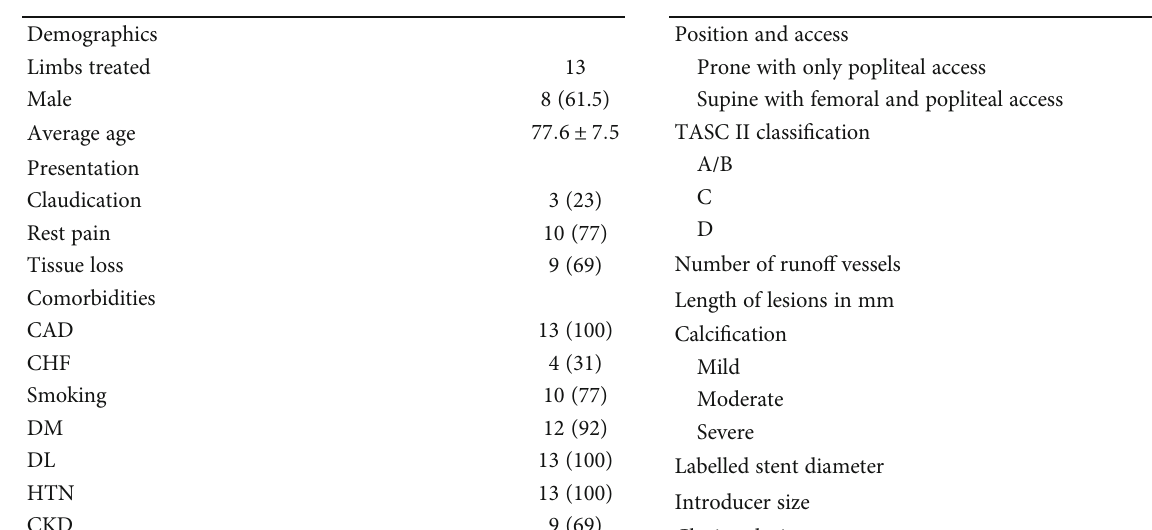
Table 1: Characteristics of patients.